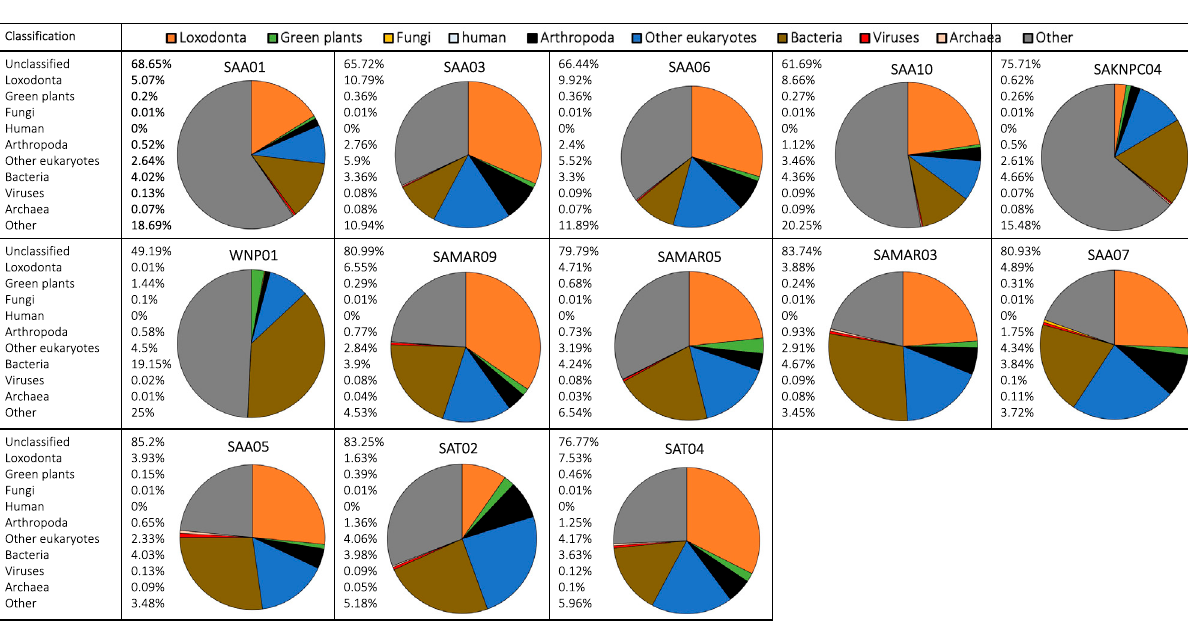
FIGURE 2 Metagenomicclassi fi cationoffecalDNAsamplesfrom13free-rangingelephantsfromSouthAfrica.Compositionaltaxonomiccontributionsof classi fi ed reads are summarized as a pie chart for each individual (unclassi fi ed reads are not shown). Taxonomic groups have been color coded and corresponding colors are indicated in the legend in the top row of the fi gure. Taxonomic classi fi cation showed that most samples contained reads that originated from bacteria, endogenous elephant DNA, green plants, arthropods, and other